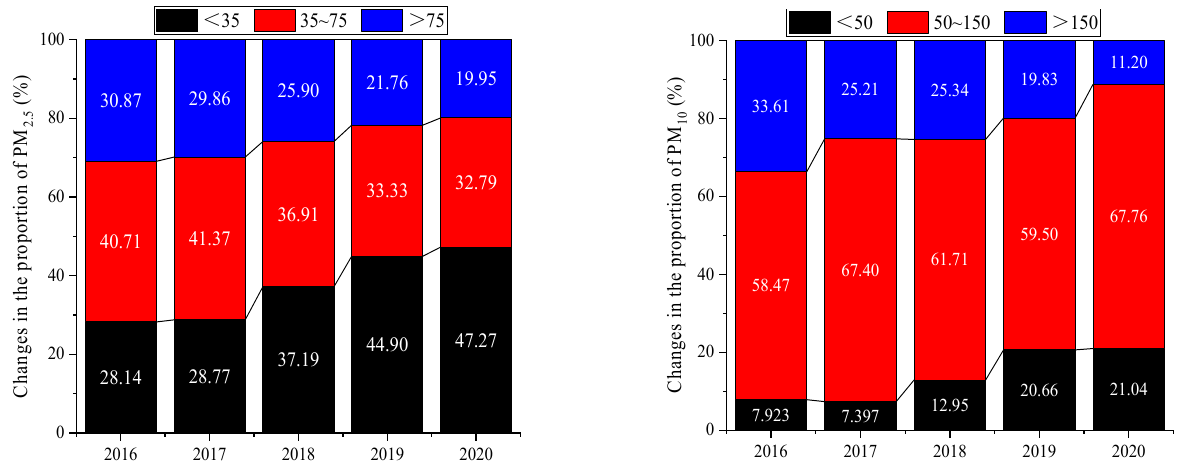
Figure 1. Changes in PM 2.5 and PM 10 concentrations from 2016 to 2020.